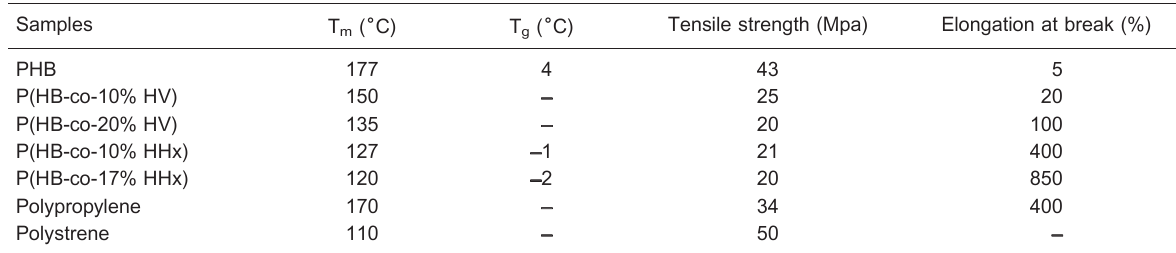
Table 1. Physical properties of various polyhydroxyalkanoates compared with conventional plastics.